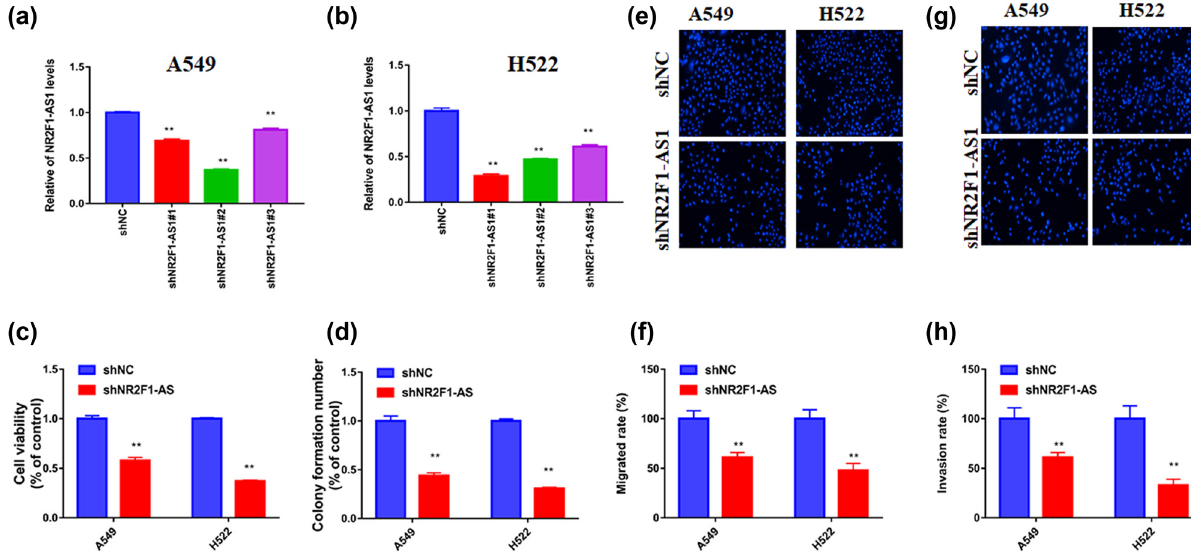
Figure 2: NR2F1 - AS1 silencing blocked NSCLC progression in vitro . A549 and H522 cells were transfected with sh - NC or sh - NR2F1 - AS1. ( a and b ) The level of NR2F1 - AS1 was assessed to check the transfection e ffi ciency of shRNA1 - 3. ( c ) The CCK8 assay, ( d ) colony formation assay, ( e and f ) transwell assay, and ( g and h ) invasion assay were operated to determine NSCLC progression in vitro . ** P < 0.01.